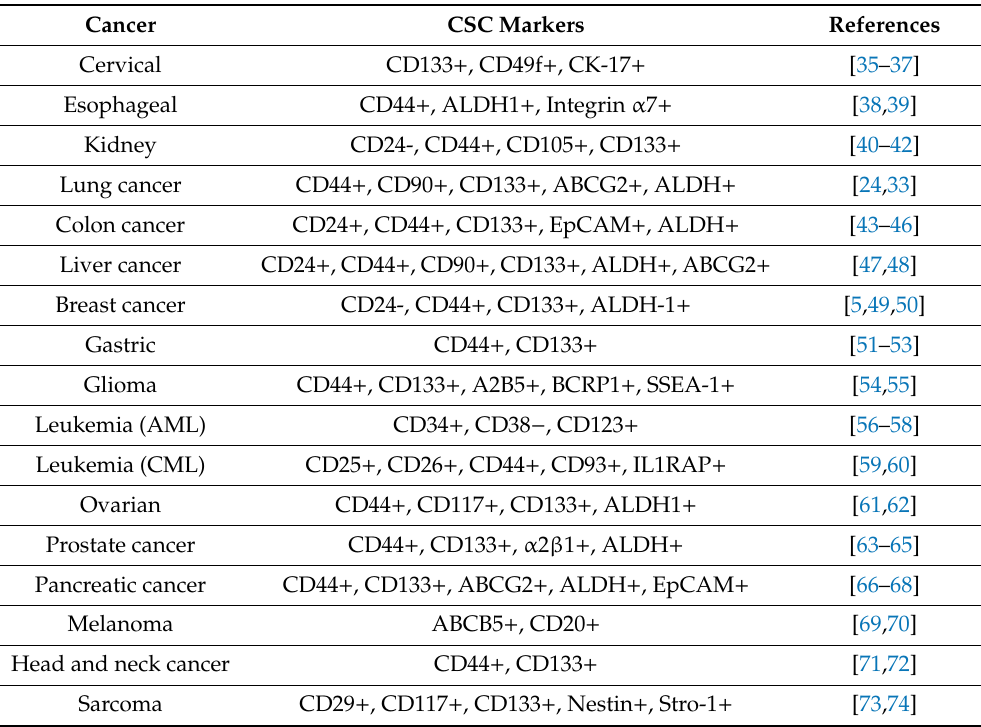
Figure 2. Cancer stem cell markers expressed in some human cancers are shown in the figure. Figure adapted from Dzobo et al. [34]. See Table 1 for references. The list of CSC markers is not exhaustive. The CSC markers continue to be refined based on new data. Table 1. CSC markers expressed in different human cancers*.